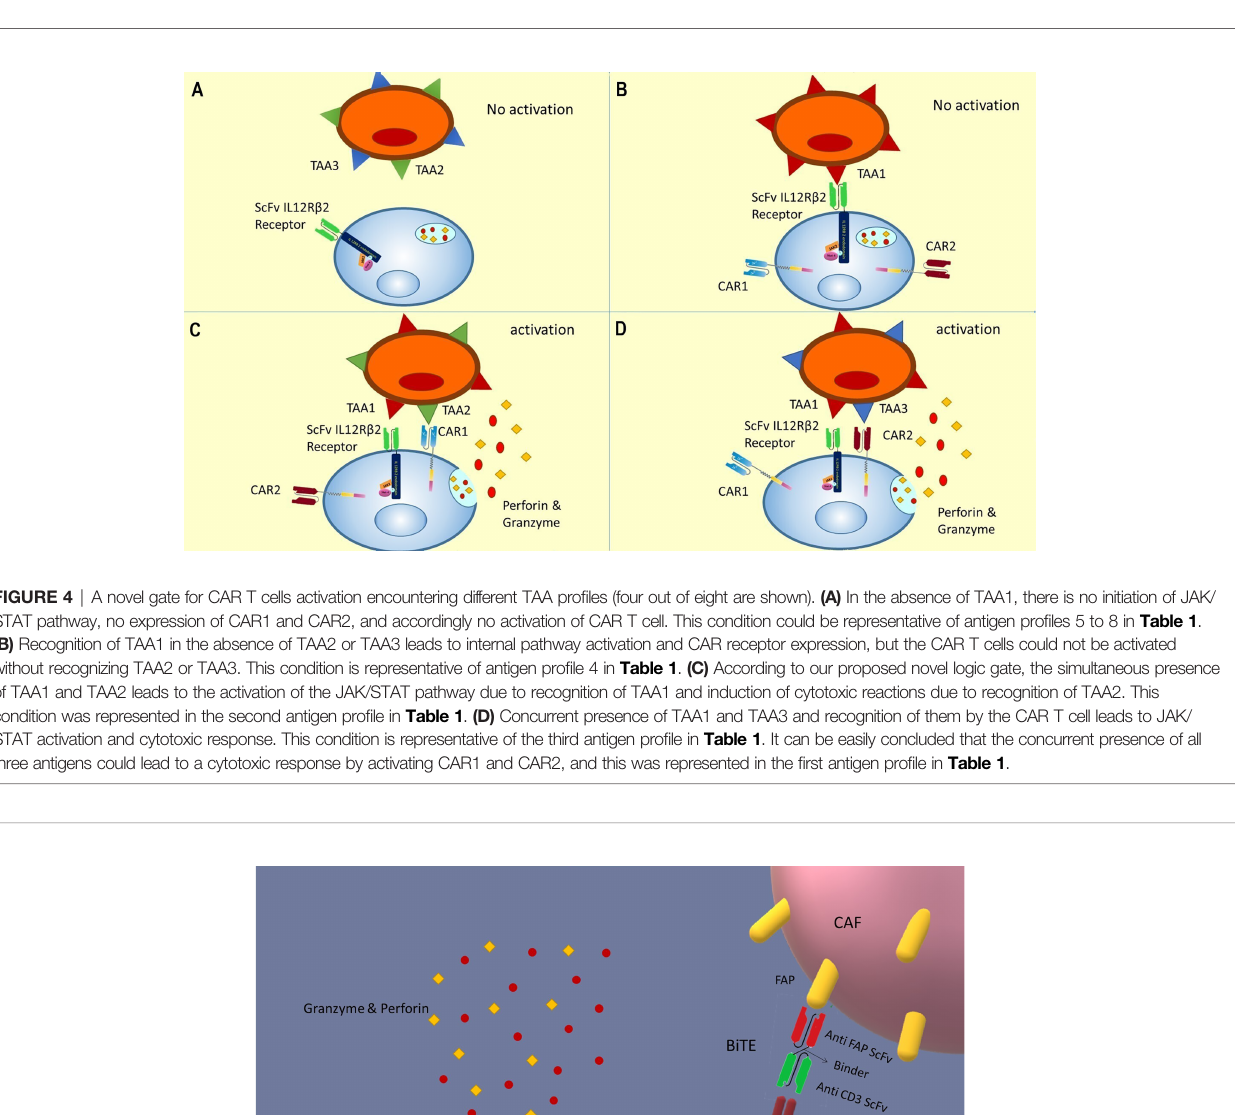
cell survival through Bcl-2, Bcl-XL, and MCL1 anti-apoptotic